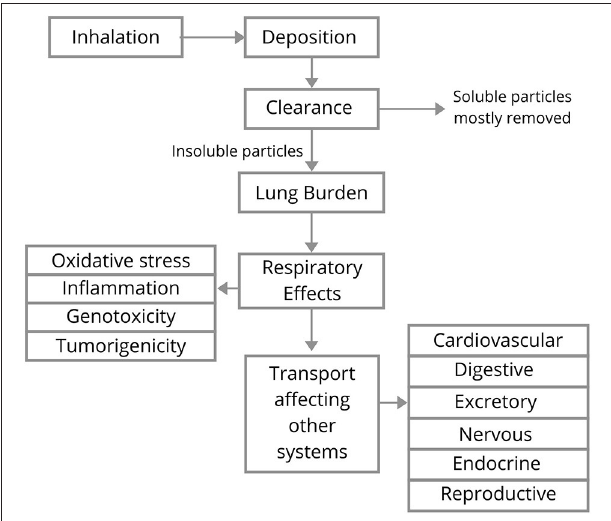
FIGURE 3 | Overview of pathway of nanoparticles from inhalation to disease